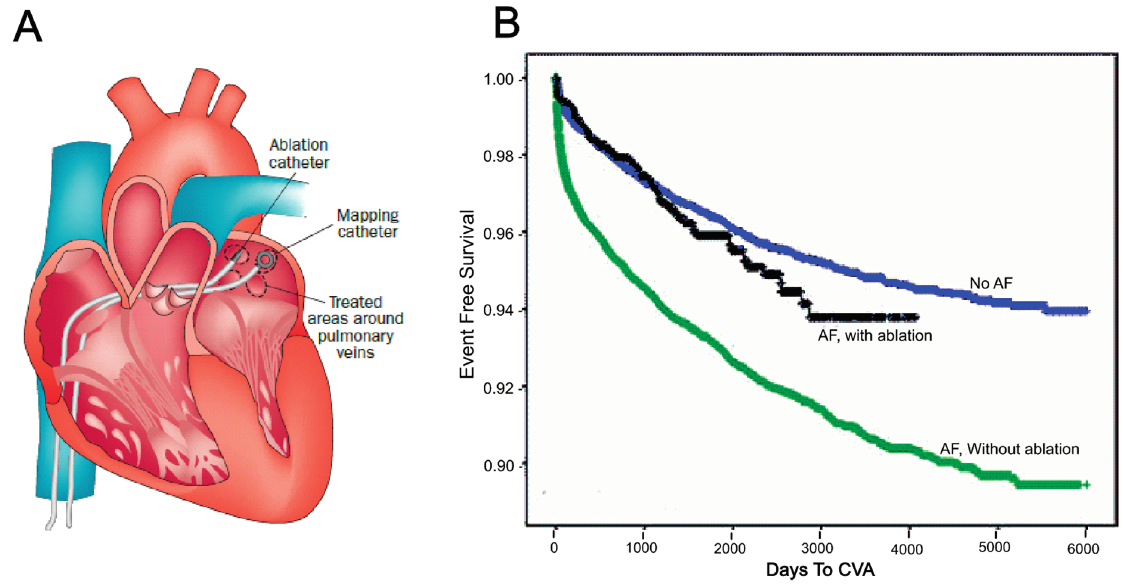
Figure 1. Catheter ablation and its benefits. ( A ) Ablation and mapping catheters were deployed in the left atrium for pulmonary vein (PV) isolation [9]. Reprinted from [9] with permission from Nature Publishing Group; ( B ) Long-term cerebrovascular accident (CVA) free in days for atrial fibrillation (AF) patients with and without ablation compared with those who have no history of AF [8]. Reprinted from [8] with permission from John Wiley and